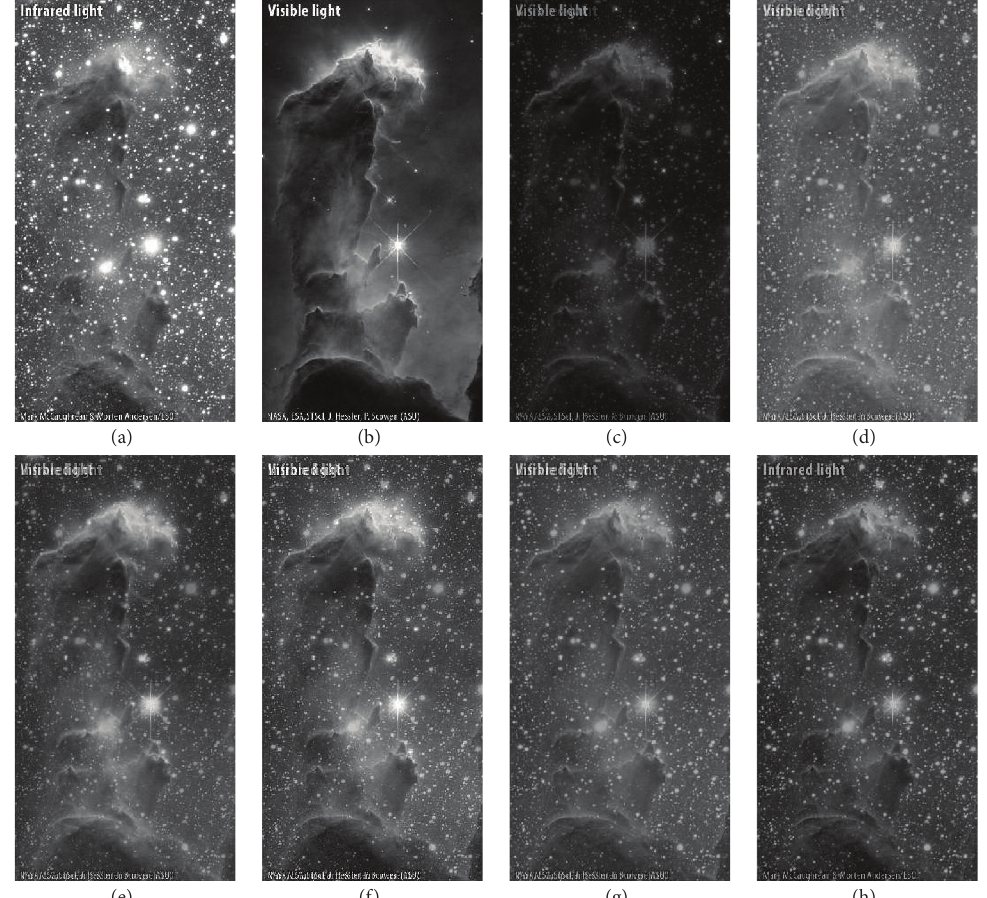
Figure 5: Nabula (M16): (a) IR image, (b) visible image, (c) RP [25] fusion, (d) DTCWT [26] fusion, (e) NSCT [27] fusion, (f) MSVD [28] fusion, (g) Ellmauthaler et al. [8] fusion, and (h) proposed